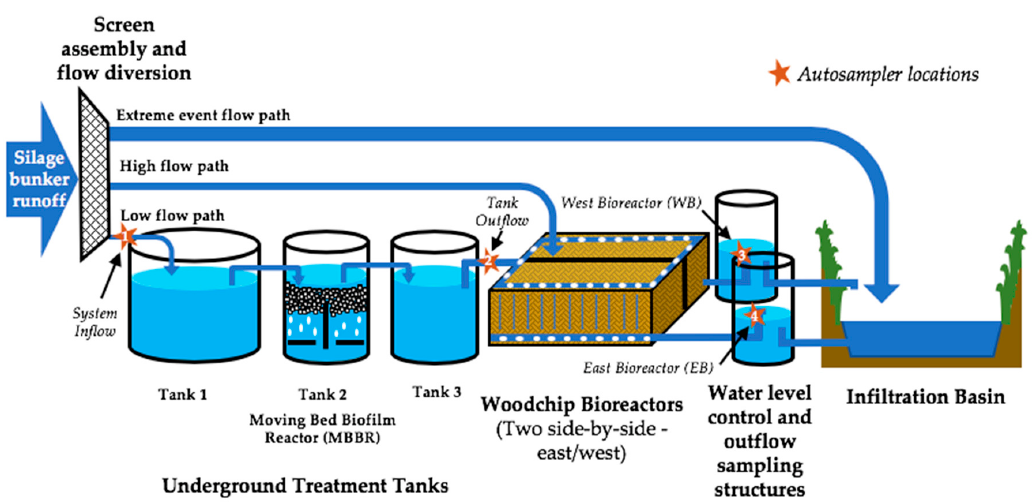
Figure 2. Conceptual schematic diagram of the runoff flow pathways through the treatment system, low flow, high flow, and extreme events. Numbered stars indicate autosampler locations; (1) System Inflow, (2) Tank Outflow, (3) West Bioreactor (WB), (4) East Bioreactor (EB).